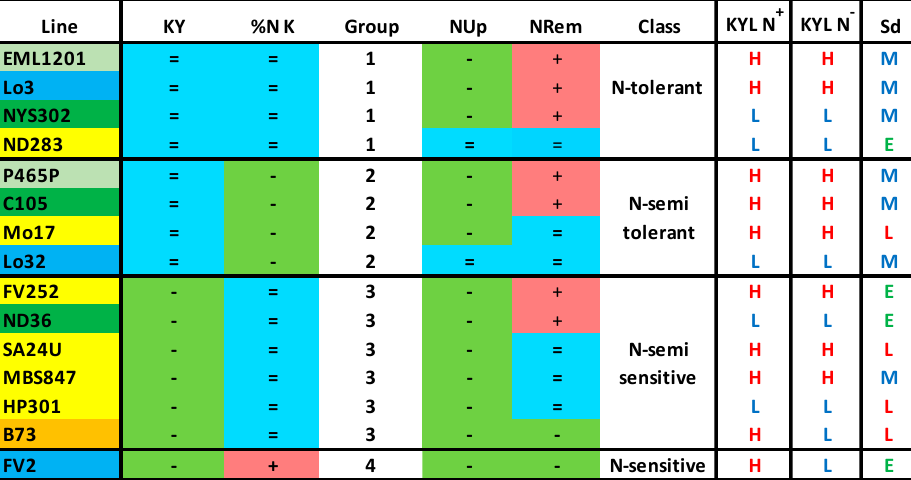
Figure 1. Schematic representation of the distribution of the 15 maize inbred maize lines originating from Europe and America in relation to their agronomic performance and their mode of N management under post-silking N-limiting conditions. On the left of the panel (Line), colored boxes represent the five groups of maize lines obtained from different countries of Europe and America (Tropical: pale green; European Flint: Blue; Northern Flint: dark green; Corn Belt Dent: yellow and Stiff Stalk: orange). Kernel yield (KY), kernel number (KN) and kernel N content (%NK) were determined for the 15 maize lines grown in the glass house (Table 1). For the different measured traits including KY, %NK, N remobilization (NRem) and N uptake (NUp) the red background color indicates an increase (+), the green background color a decrease (-) and the blue background color no change (=) under N-limiting conditions after silking until plant maturity. Groups 1, 2, 3 and 4 represent the four groups of lines identified on the basis of KY and %NK. Class corresponds to a proposed ranking of the lines based on their N management response when post-silking N fertilization is reduced. On the right of the panel, the period for the silking date (Sd) is shown. E = early (from 4th to the 18th of June); M = medium (from the 19th to the 29th of June); L = late (from the 30th of June to the 6th of July), along with the level of kernel yield in N + (KYL N + ) and in N − (KYL N − ); H = High > 50 g and up to 120 g per plant; L= low < 50 g and down to 30g per plant. Detailed yield data are presented in Table 1.